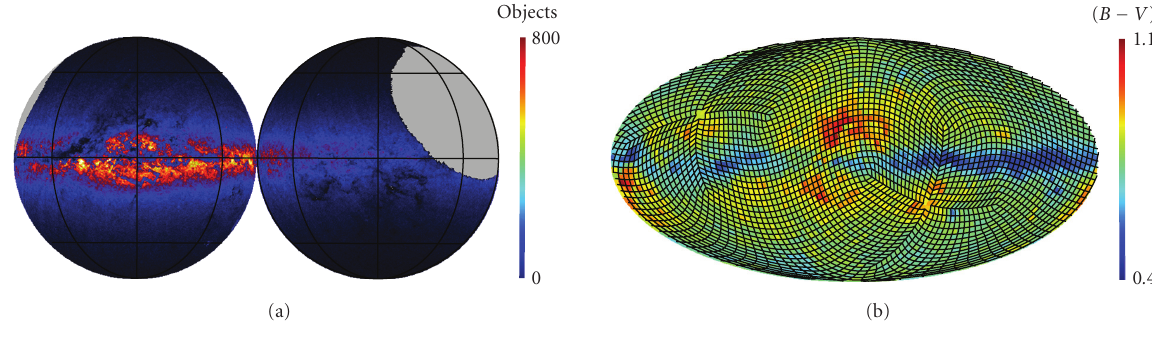
Figure 4: UCAC 2.0 full sky objects density map (a) and ASCC 2.5 objects average B − V